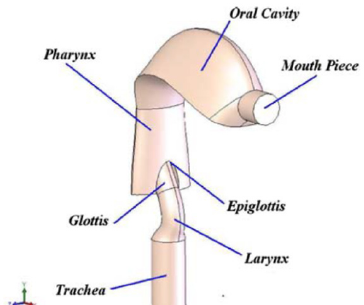
Figure 8. Hybrid idealized geometry. Reprinted with permission from Ref. [46] 2007, T. P. Collins et al.